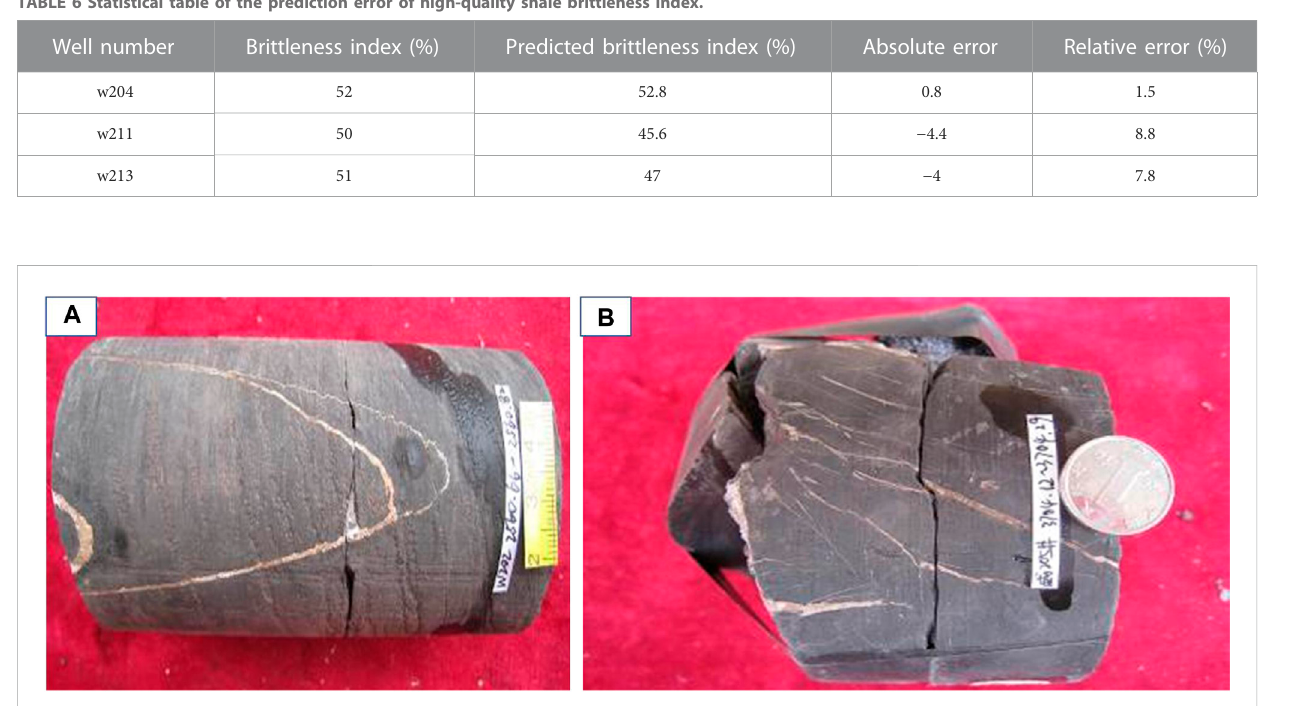
FIGURE 15 Rockcorephotos[ (A) calcitefull- fi lledhigh-anglefractures,W202well,2560 m (B) calcitefull- fi lledmultiplehigh-anglefractures,obliquefractures, W205 well, 3704 m].